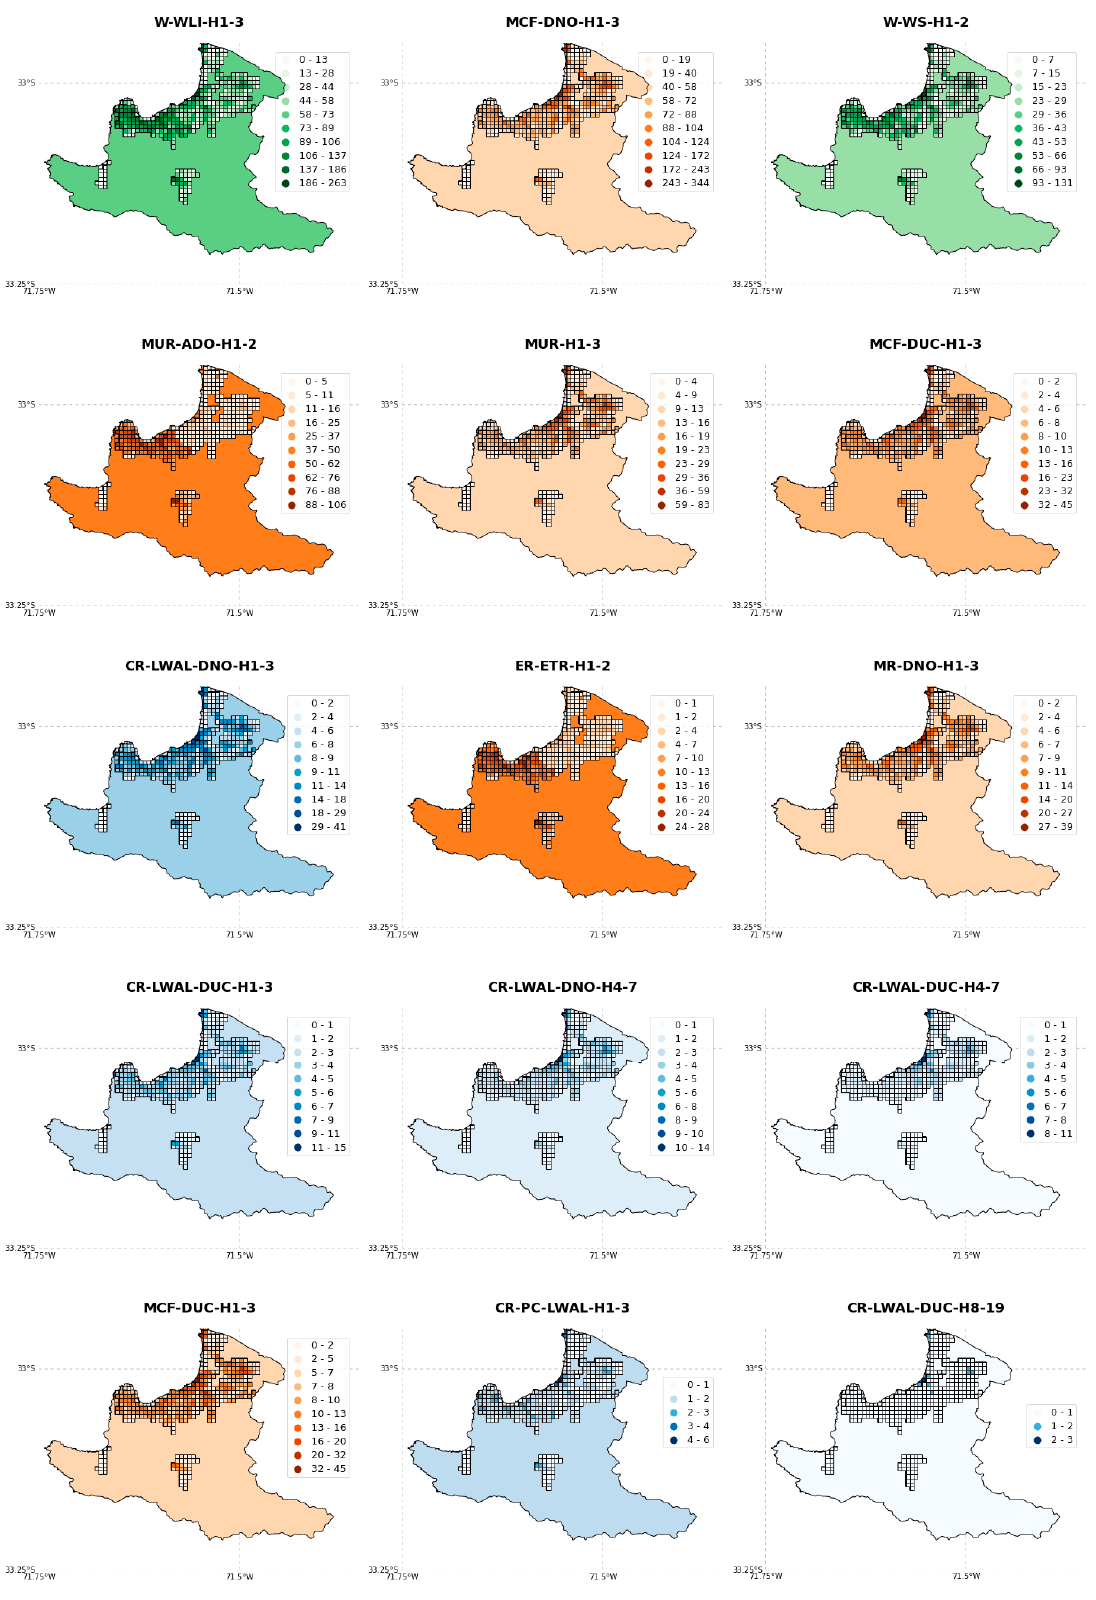
Figure 7. Spatial distributions of the building counts for the SARA typologies obtained from the preliminary downscaled model. The colour scale reflects the material type (green = wooden; orange = masonry; blue = reinforced concrete).